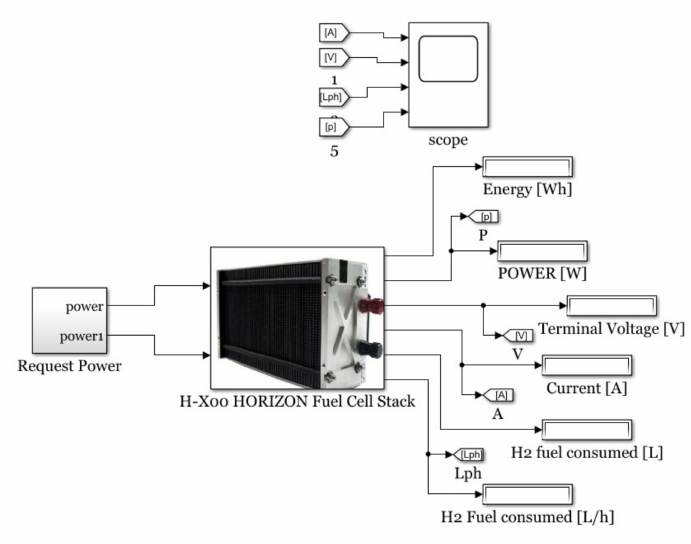
Figure 10. Top view of the FC